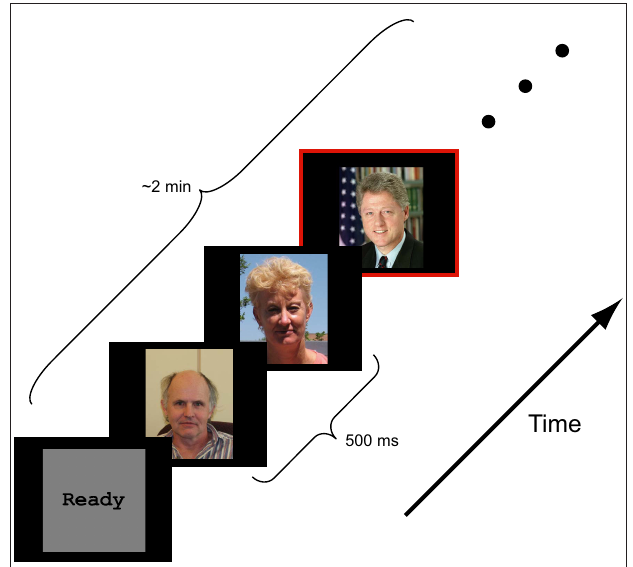
Figure 1 | Schematic representation of experimental design. Color photographs of faces were presented in a rapid serial sequence (500 ms per face). Participants were asked to respond, via button press, only when a target face (Presidents Obama, Bush, and Clinton) appeared. Besides the target face, the stimulus ensemble included faces of novel individuals, famous persons selected by the participant and personal friends and family provided by the